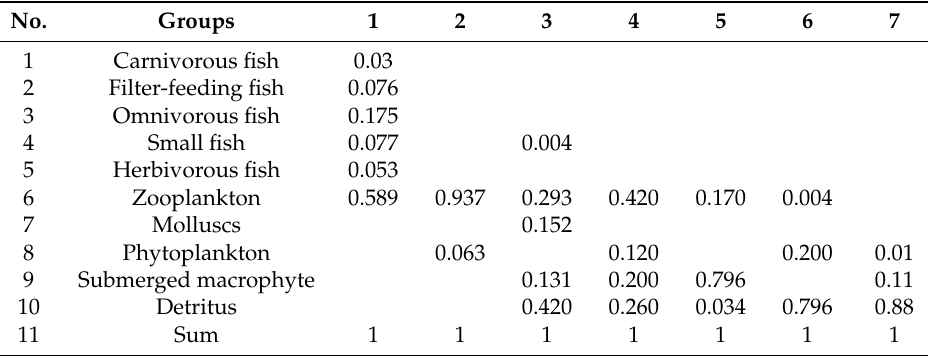
Table A2. Diet compositions of the Lake Datong